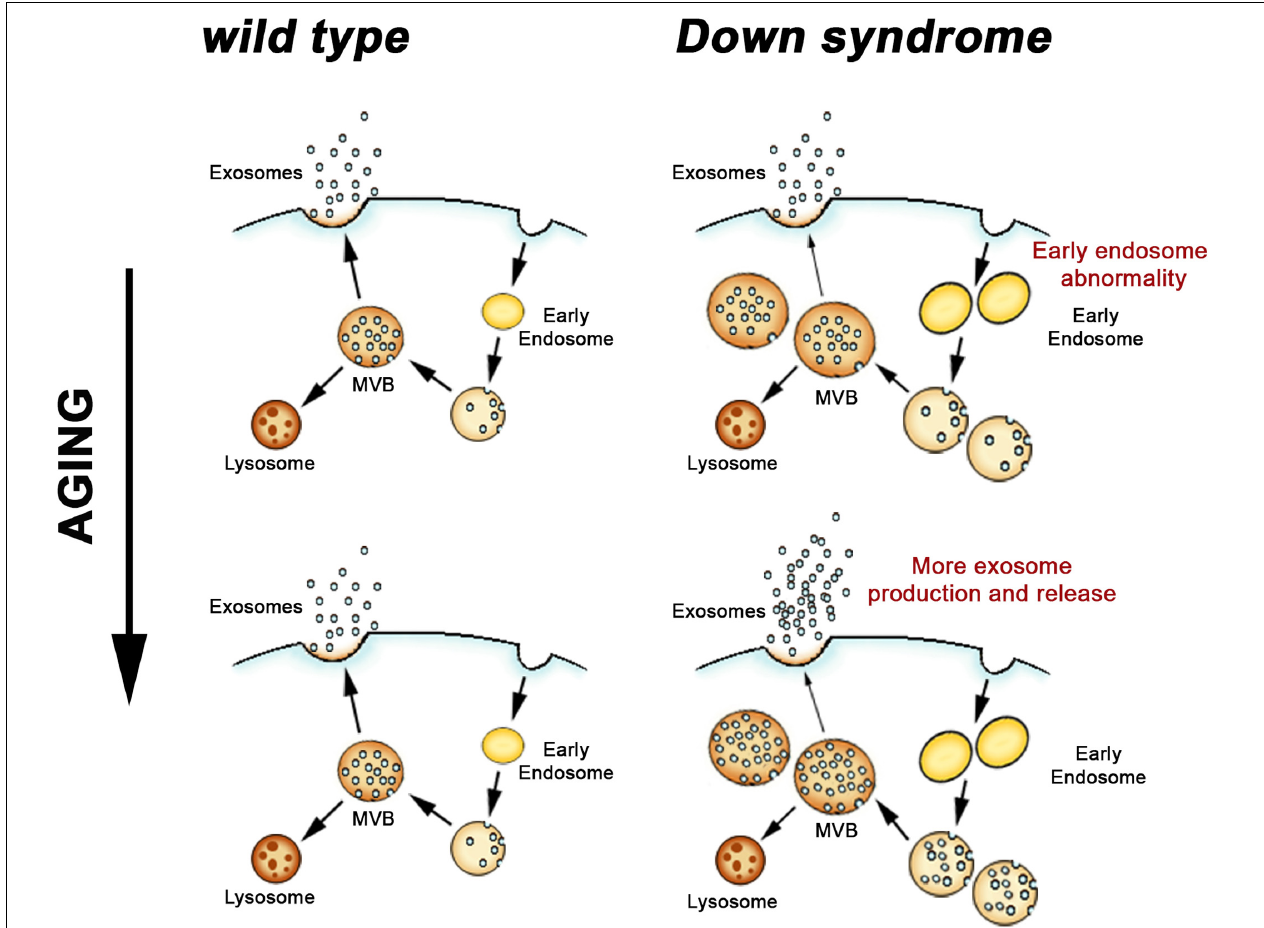
FIGURE 2 | Endosomal and exosomal changes in the DS brain. Endocytosed material is sorted through early endosomes and late endosomes/MVB for either degradation in lysosomes or exosomal secretion. In DS, where neuronal endosome dysfunction begins before birth, an age-dependent increase in exosome release appears to be a compensatory response to limit the extent of the endosomal pathway pathology that results from DS genetic